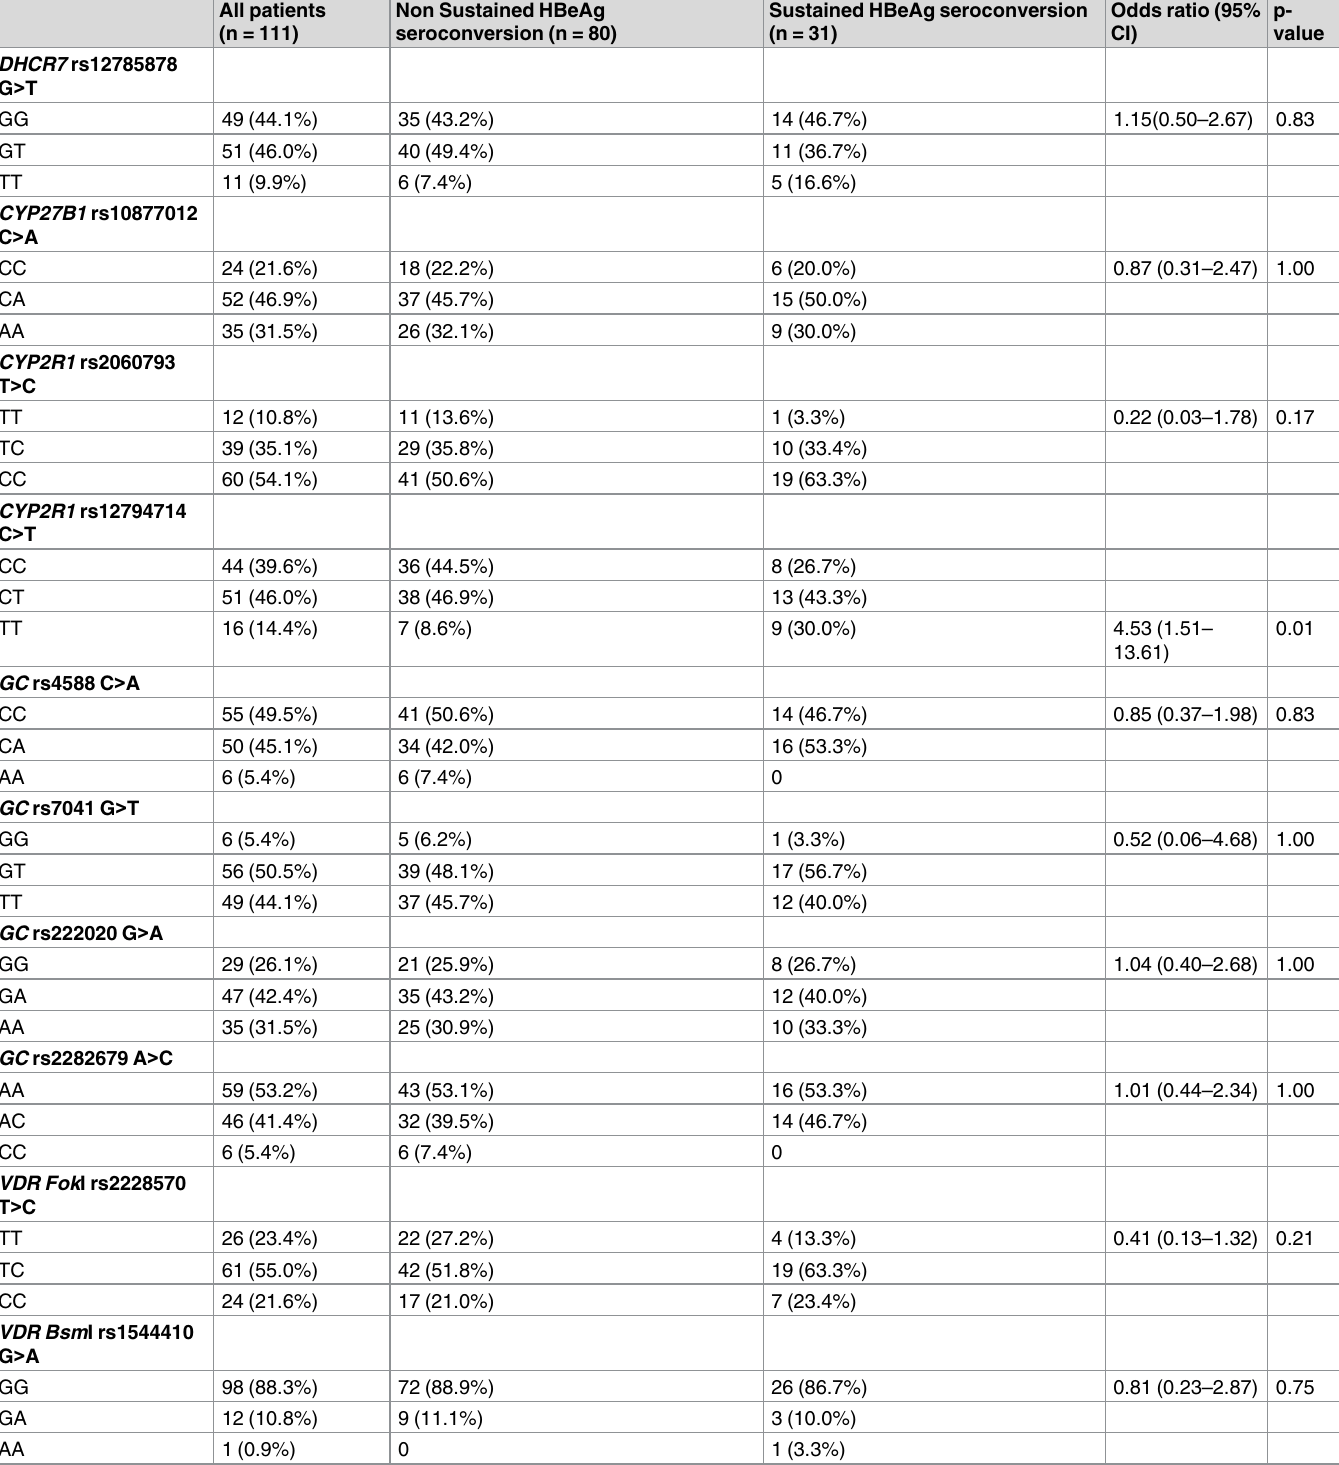
Table 2. Genotype frequencies of DHCR7 , CYP27B1 , CYP2R1 , GC and VDR in HBeAg-positive chronic hepatitis B patients treated with PegIFN for 48 weeks. All patients (n =